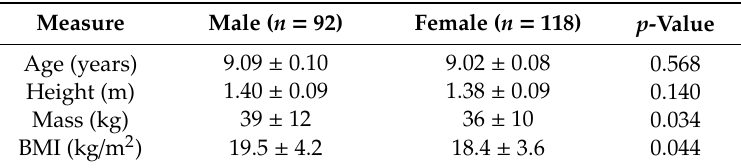
Table 1. Descriptive statistics of anthropometric and physical fitness indicators. Data is present as mean ± standard deviation (SD).